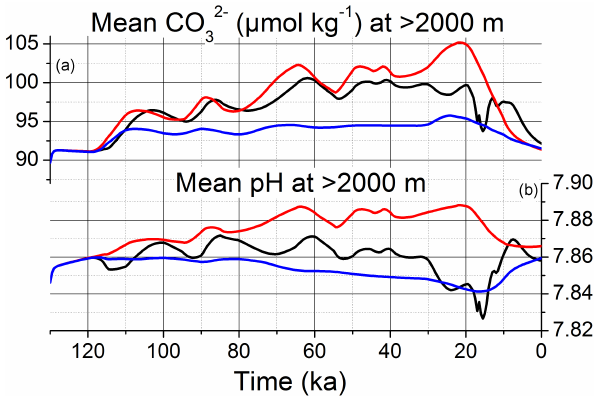
Figure 10. Global mean carbonate ion concentrations (a) and pH values (b) below 2000m water depth for simulations STD (black line), STD-CC (red line), and STD-CC-CN (blue